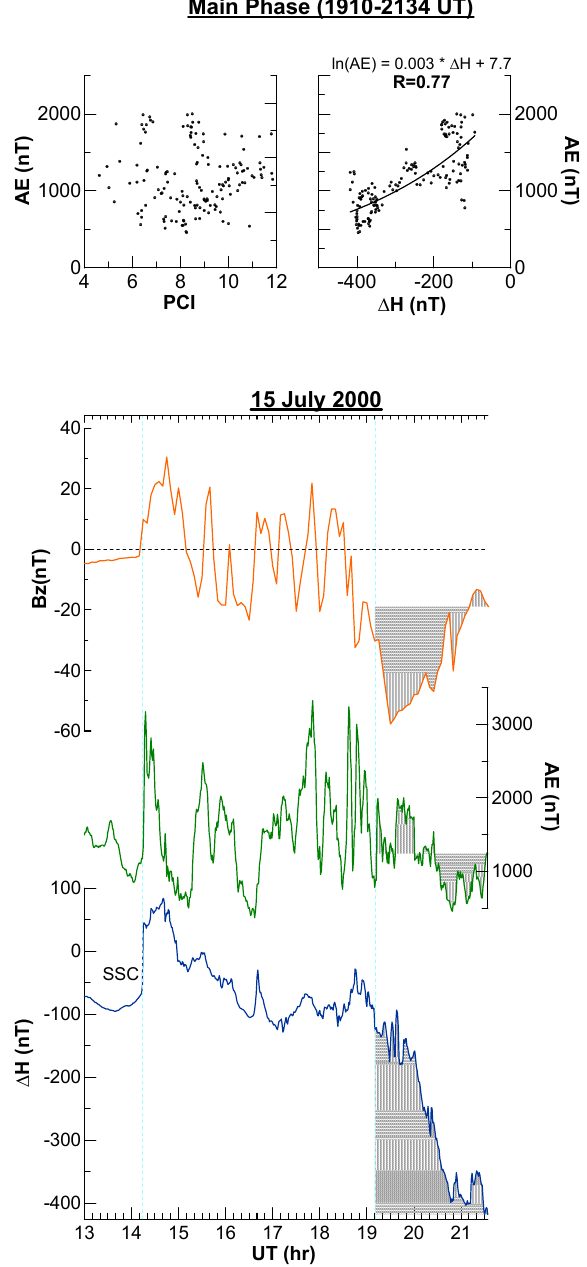
Fig. 9. Upper panel displays the correlations of the polar cap magnetic activity ( PC ) index and low-latitude geomagnetic field 1H ABG with auroral electrojet ( AE ) index for 15 July 2000 for “ T 1” (19:10–21:34 UT) period. Bottom panel shows the variations of auroral electrojet index ( AE ) and horizontal component of geo- magnetic field at Alibag ( 1H ABG ) with corresponding interplane- tary magnetic field (IMF) north-south component B z